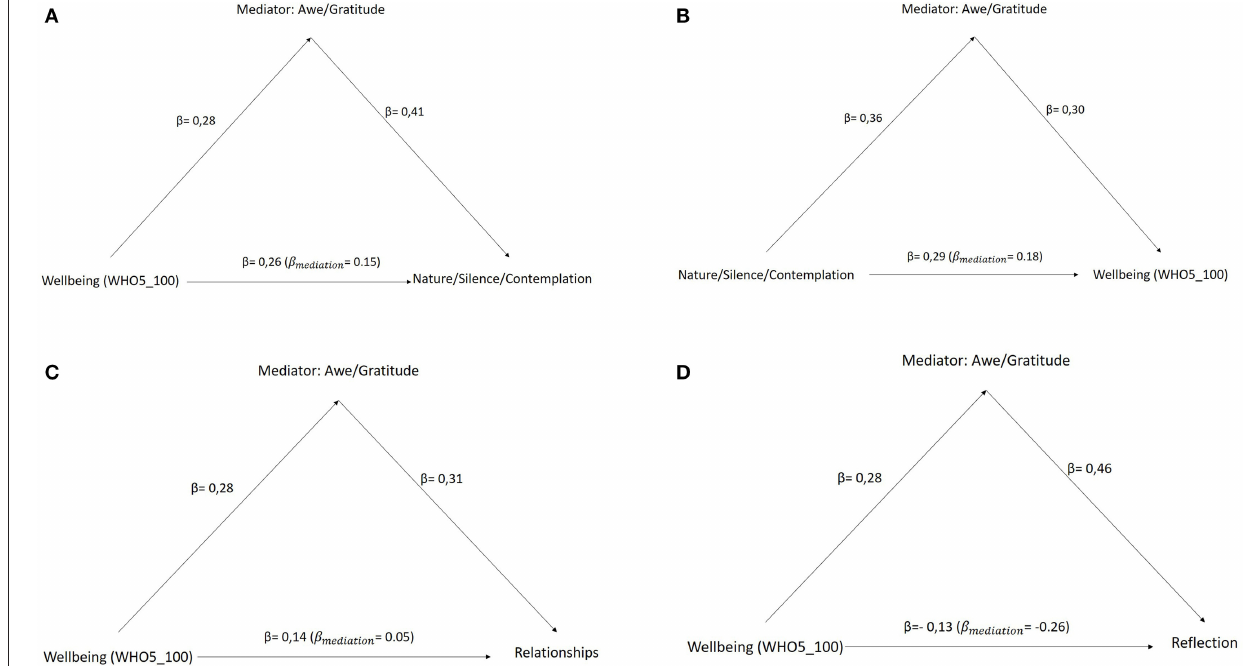
FIGURE 1 | Different mediation models with Awe/Gratitude as mediator. Well-being as predictor and Nature/Silence/Contemplation as outcome mediated by Awe/Gratitude (A) . The proportion of causal effect explained by the mediator is 42%, direct effect is 0.15, and total effect is 0.26. Nature/Silence/Contemplation as predictor and well-being as outcome mediated by Awe/Gratitude (B) . The proportion of causal effect explained by the mediator is 38%, direct effect is 0.18, and total effect is 0.29. Well-being as predictor and Relationships as outcome mediated by Awe/Gratitude (C) . The proportion of causal effect explained by the mediator is 62%, direct effect is 0.05, and total effect is 0.14. Well-being as predictor and Reflection as outcome mediated by Awe/Gratitude (D) . The proportion of causal effect explained by the mediator is 95%, direct effect is − 0.26, and total effect is −